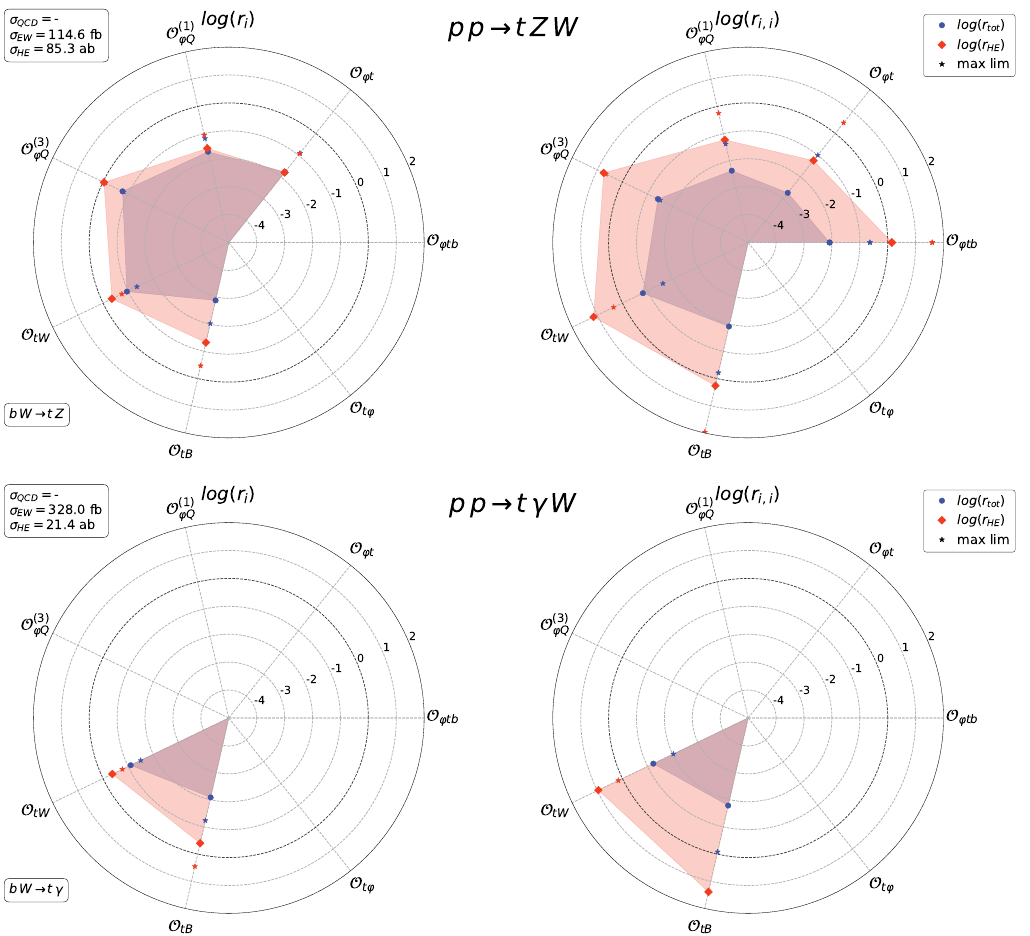
Figure 11. Radar plot for the process p p (cid:12)gure 9 and section 4.1.2 of the main text for a detailed